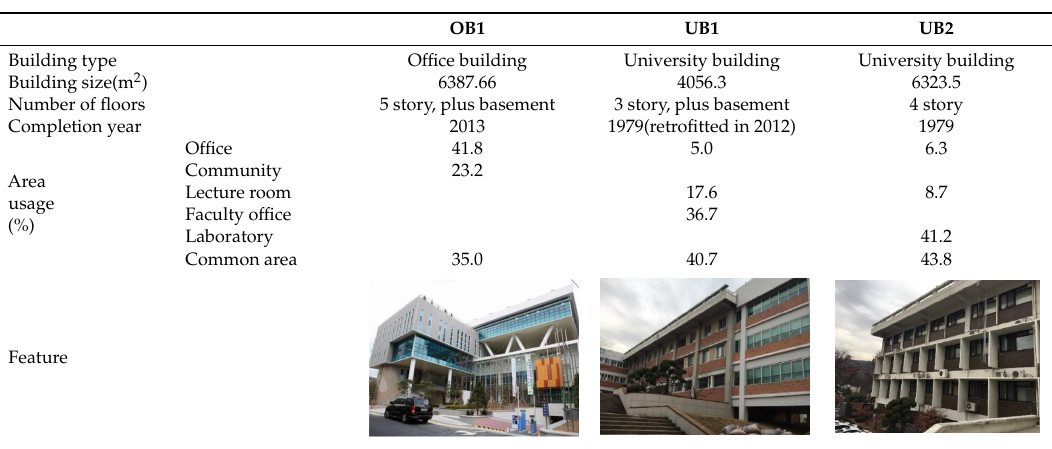
Table 4. Description of the buildings studied.